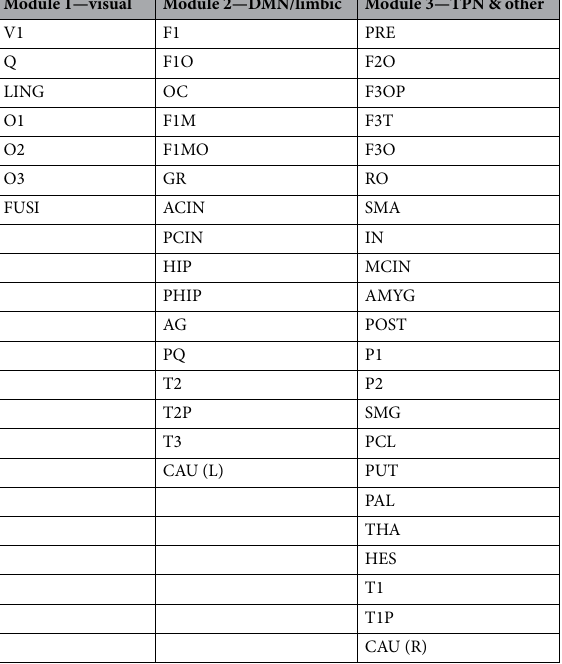
Table 7. Modules of ActS rule. The network includes three main clusters: the visual cortex; the limbic/DMN; the sparse brain regions belonging to the TPN. Unless explicitly indicated, all modules refer to both (L/R)